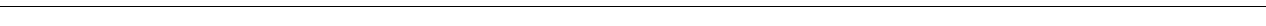
Figure 3 | Notch1 can enter autophagosomes independently from endocytosis. ( a ) Autophagosomes (LC3-positive) can fuse with early endosomes (EEA1-positive) forming amphisomes. ( b ) HEK cells were transfected with pEGFP-LC3 and then treated with DMSO (control) or rapamycin, immunostained for Notch1 (red) and EEA1 (white) and DAP-stained (blue). c shows Notch1-EEA1-only colocalization, - indicates LC3-Notch1-only colocalization, - indicates triple colocalization. Scale bar, 5 m m. ( c ) Quantification of vesicles positive for Notch1 and LC3, Notch1 and EEA1, or Notch1 and LC3 and EEA1, in DMSO (Co, grey) and rapamycin (rap, black) conditions. The percentage for each relative to total counted vesicles is shown. * P o 0.05, unpaired t- test. n ¼ 3. Error bars ¼ s.e.m. ( d ) HEK cells were treated with DMSO (control) or rapamycin for 8h. Arrows show Notch1- and EEA1-positive vesicles. White box indicates location of enlargement shown in the three preceding images. Scale bar, 5 m m ( e ) Quantification of confocal images (Mander’s colocalization) between Notch1 and EEA1 from 3d. NS denotes not significant, unpaired t -test. n ¼ 3. Error bars ¼ s.e.m. ( f ) Quantification of number of total EEA1 vesicles in DMSO- and rapamycin-treated conditions. NS denotes not significant, unpaired t -test. n ¼ 3. Error bars ¼ s.e.m. ( g ) HEK cells were transfected with mRFP-GFP-LC3 and stained for Notch1. - shows Notch1 colocalization with RFP- and GFP-positive structures. - shows Notch1 colocalization with RFP-positive, GFP-negative structures. Scale bar ¼ 5 m m. ( h ) Quantification of vesicles positive for GFP and RFP with/without Notch1, and RFP-only vesicles with/without Notch1. Total number of vesicles is total number of (GFP and RFP) þ RFP-only positive vesicles. The number of Notch1-positive or -negative vesicles is divided by the total number of vesicles. n ¼ 3. Error bars ¼ s.e.m. ( i ) HEK cells were transfected with pEGFP-LC3 and stained against LAMP1 and Notch1. - shows Notch1 colocalization with EGFP-LC3 and LAMP1. - shows Notch1 colocalization with LC3-positive, but LAMP1-negative structures. Scale bar, 5 m m. ( j ) Quantification of vesicles positive for LC3, or LC3-LAMP1 double-positive, or LAMP1- positive vesicles with/without Notch1. Total number of vesicles is the total number of LC3-only þ LC3-LAMP þ LAMP1-only positive vesicles. The number of Notch1-positive or -negative vesicles is divided by the total number of vesicles. n ¼ 3. Error bars ¼